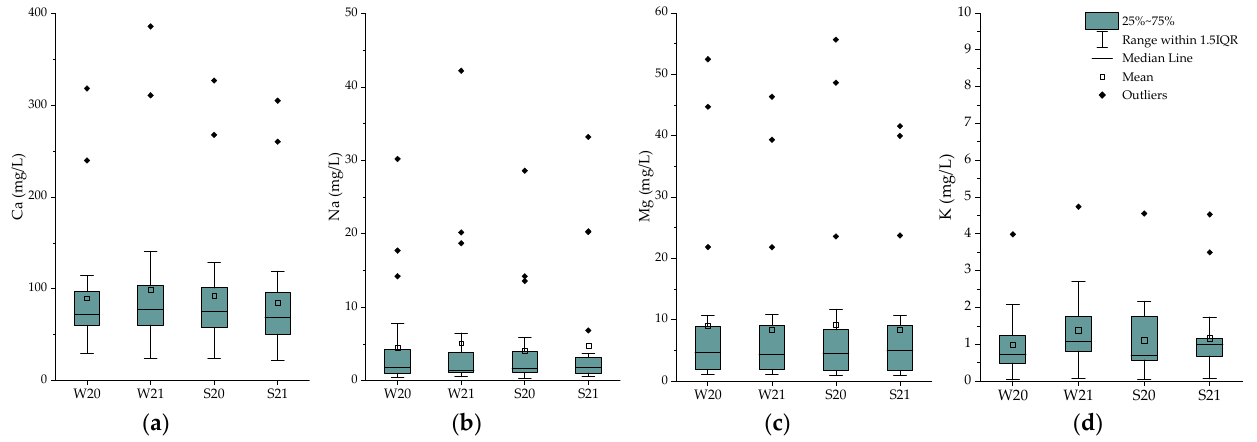
Figure 3. Boxplot of Ca ( a ), Na ( b ), Mg ( c ), and K ( d ) concentrations (mg/L) in groundwaters in winter (W) and spring (S) seasons of 2020 (20) and 2021 (21).